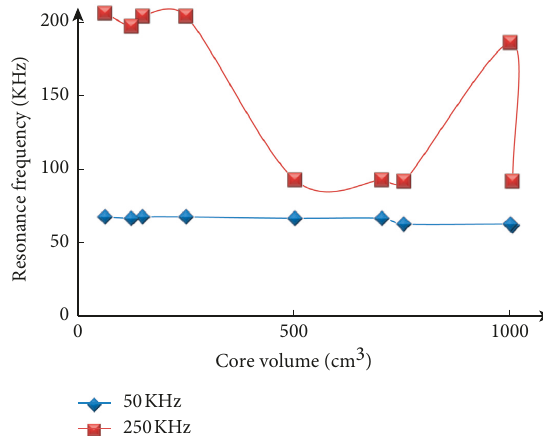
Figure 13: Relation curves of resonance frequency and volume of sandstone cores.